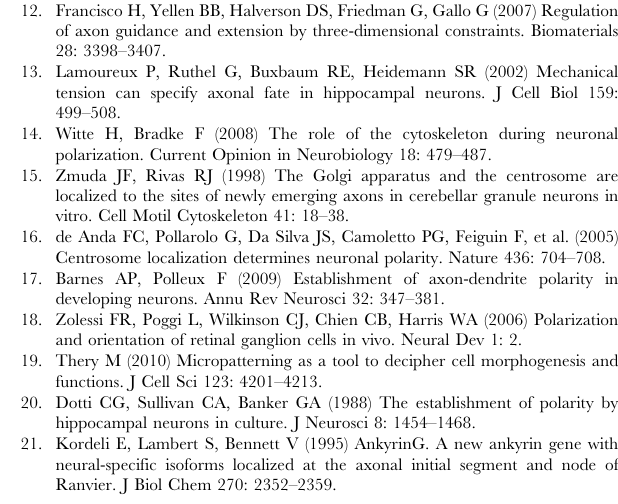
campal neuron (phalloidin-Texas red staining of actin) spread on the adhesive surface (poly-L-lysine in green). Scale bar 20 m m. (D) Micrographs of hippocampal neurons after 7 days in vitro . (Left) axonal labeling with ankyrin G (red), microtubules (tubulin, green) and nuclei (Hoechst staining, blue); (Right) dendritic marker MAP2 (green), microtubules (tubulin, red) and nuclei (Hoechst staining, blue). Scale bar= 20 m m. Figure S2 Bm, DC and DS motifs, geometrical details. (A) Geometrical dimensions of the Bm elementary motif. (B) DC and DS patterns, built with different orientations of the L2–L3 directions. Figure S3 Actin network of a stage 2 neuron (1 DIV) grown on BmS pattern. Cell nucleus (Hoechst staining, blue), centrosome ( c tubulin labeling, green), and actin (phalloidin-Texas red staining, red). No actin stress fibers are visible around the cell body. Scale bar, 10 m m. Figure S4 Summary of geometrical characteristics of DW patterns. Figure S5 Influence of neurite curvature on axonal polarization. Axonal specification along the L1–L4 directions was plotted for DW0 and for each DW4 pattern. The number of neurons polarizing along L1 increased with curvature; other neurons polarized uniformly along L2–L4 directions. ***, significantly different from random distribution (dotted line), p , 0.001. DW0: 24.4%, 24.4%, 26.0% and 25.2% for L1, L2, L3 and L4, respectively. DW4-1: 32.6%, 24.6%, 21.1% and 21.8% for L1, L2, L3 and L4, respectively. DW4-2: 34.7%, 23.6%, 23.6% and 18.2% for L1, L2, L3 and L4, respectively. DW4-3: 45.5%, 18.2%, 19.7% and 16.7% for L1, L2, L3 and L4, respectively. DW4: 52.3%, 13.3%, 18.8% and 15.1% for L1, L2, L3 and L4, respectively. Figure S6 Centrosome distribution and correlation with axonal localization in stages 2 (1 DIV) and 3 (3 DIV) neurons grown over DW4 patterns. (A) Top: an example of microtubule (green), nuclei (blue) and centrosome (red and red